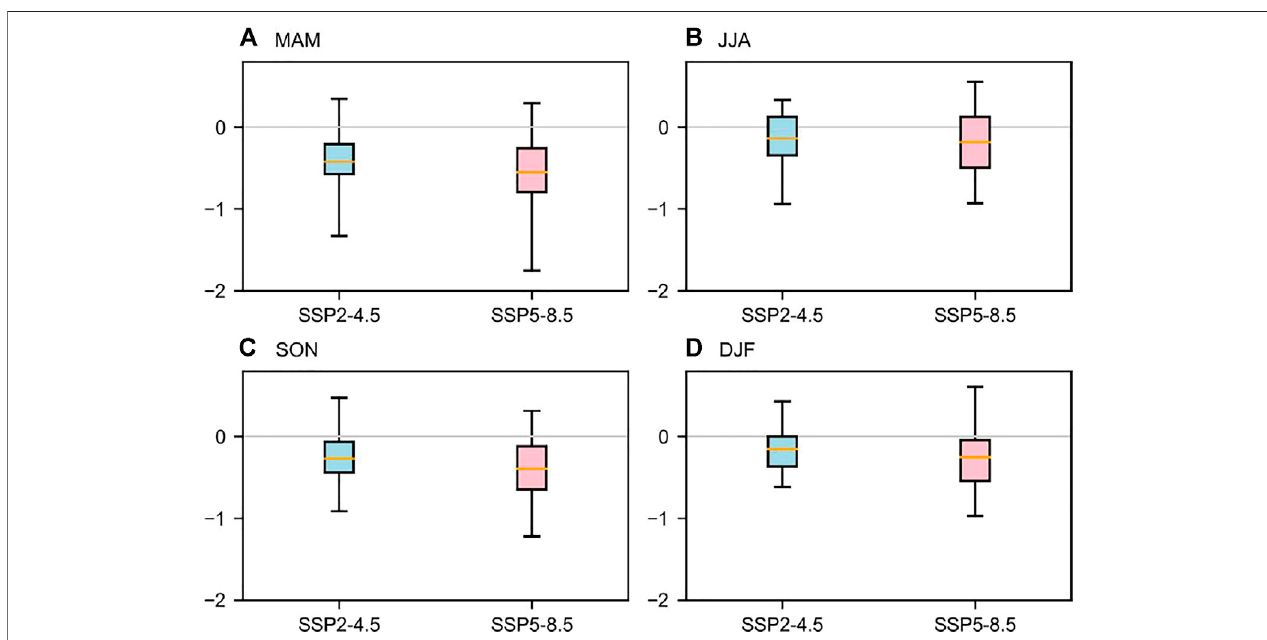
FIGURE 9 | Projected changes of (A) spring, (B) summer, (C) autumn and (D) winter APO during 2050 – 2099 relative to 1965 – 2014 under SSP2-4.5 (blue) and SSP5-8.5 (pink). Boxes indicate the interquartile model spread (25th and 75th quantiles) with the horizontal line indicating the MME and the whiskers showing the ensemble range.